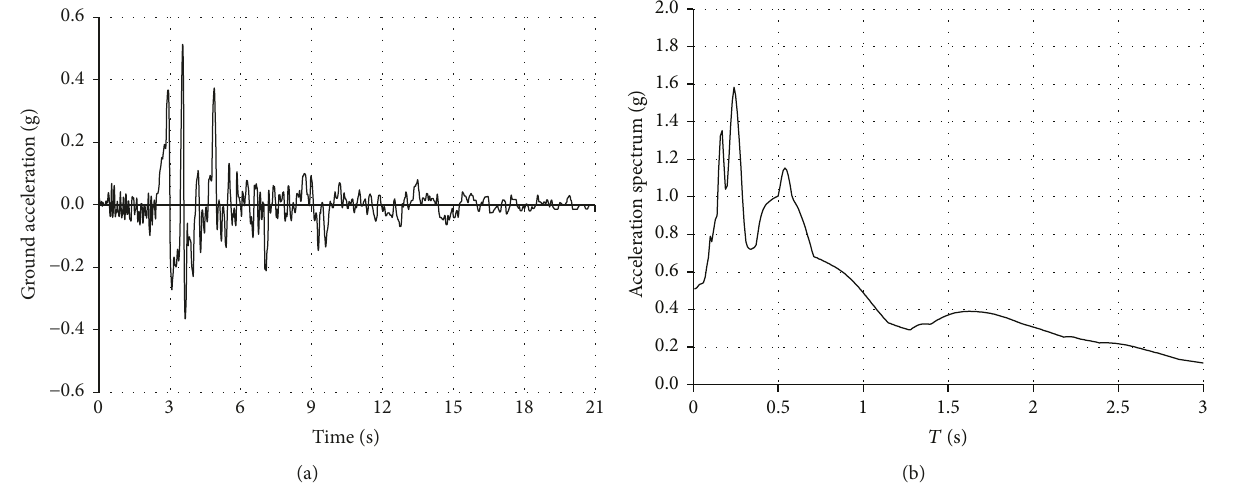
Figure 4: Erzincan earthquake: accelerogram (a) and 5% damped elastic acceleration spectra (b).